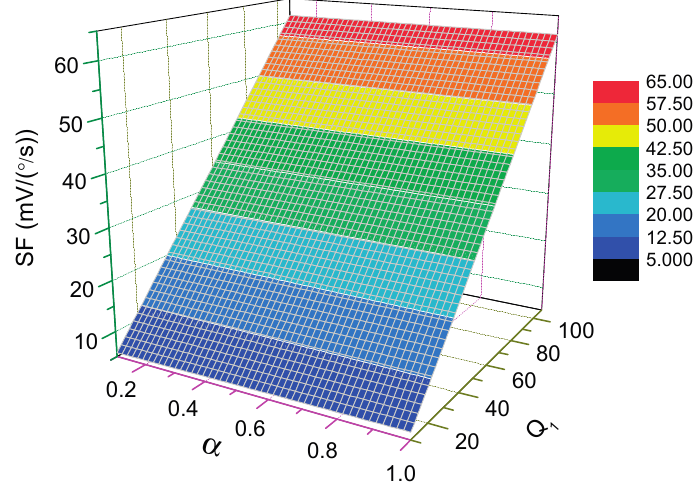
Figure 10. The dependence of scale-factor on Q -factor and (cid:2009) under mode-matched condition.